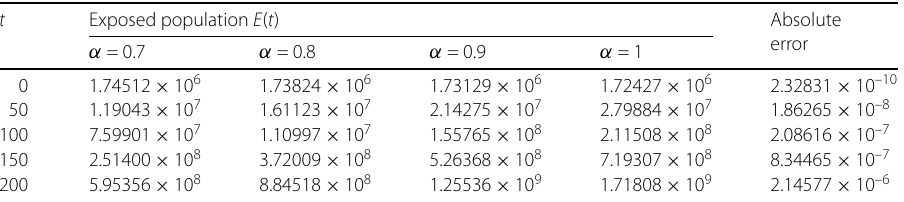
Table 3 Numerical results of exposed population E ( t ) for fractional parameter τ = 0.7,0.8,0.9,1 and comparison between classical and approximate solution